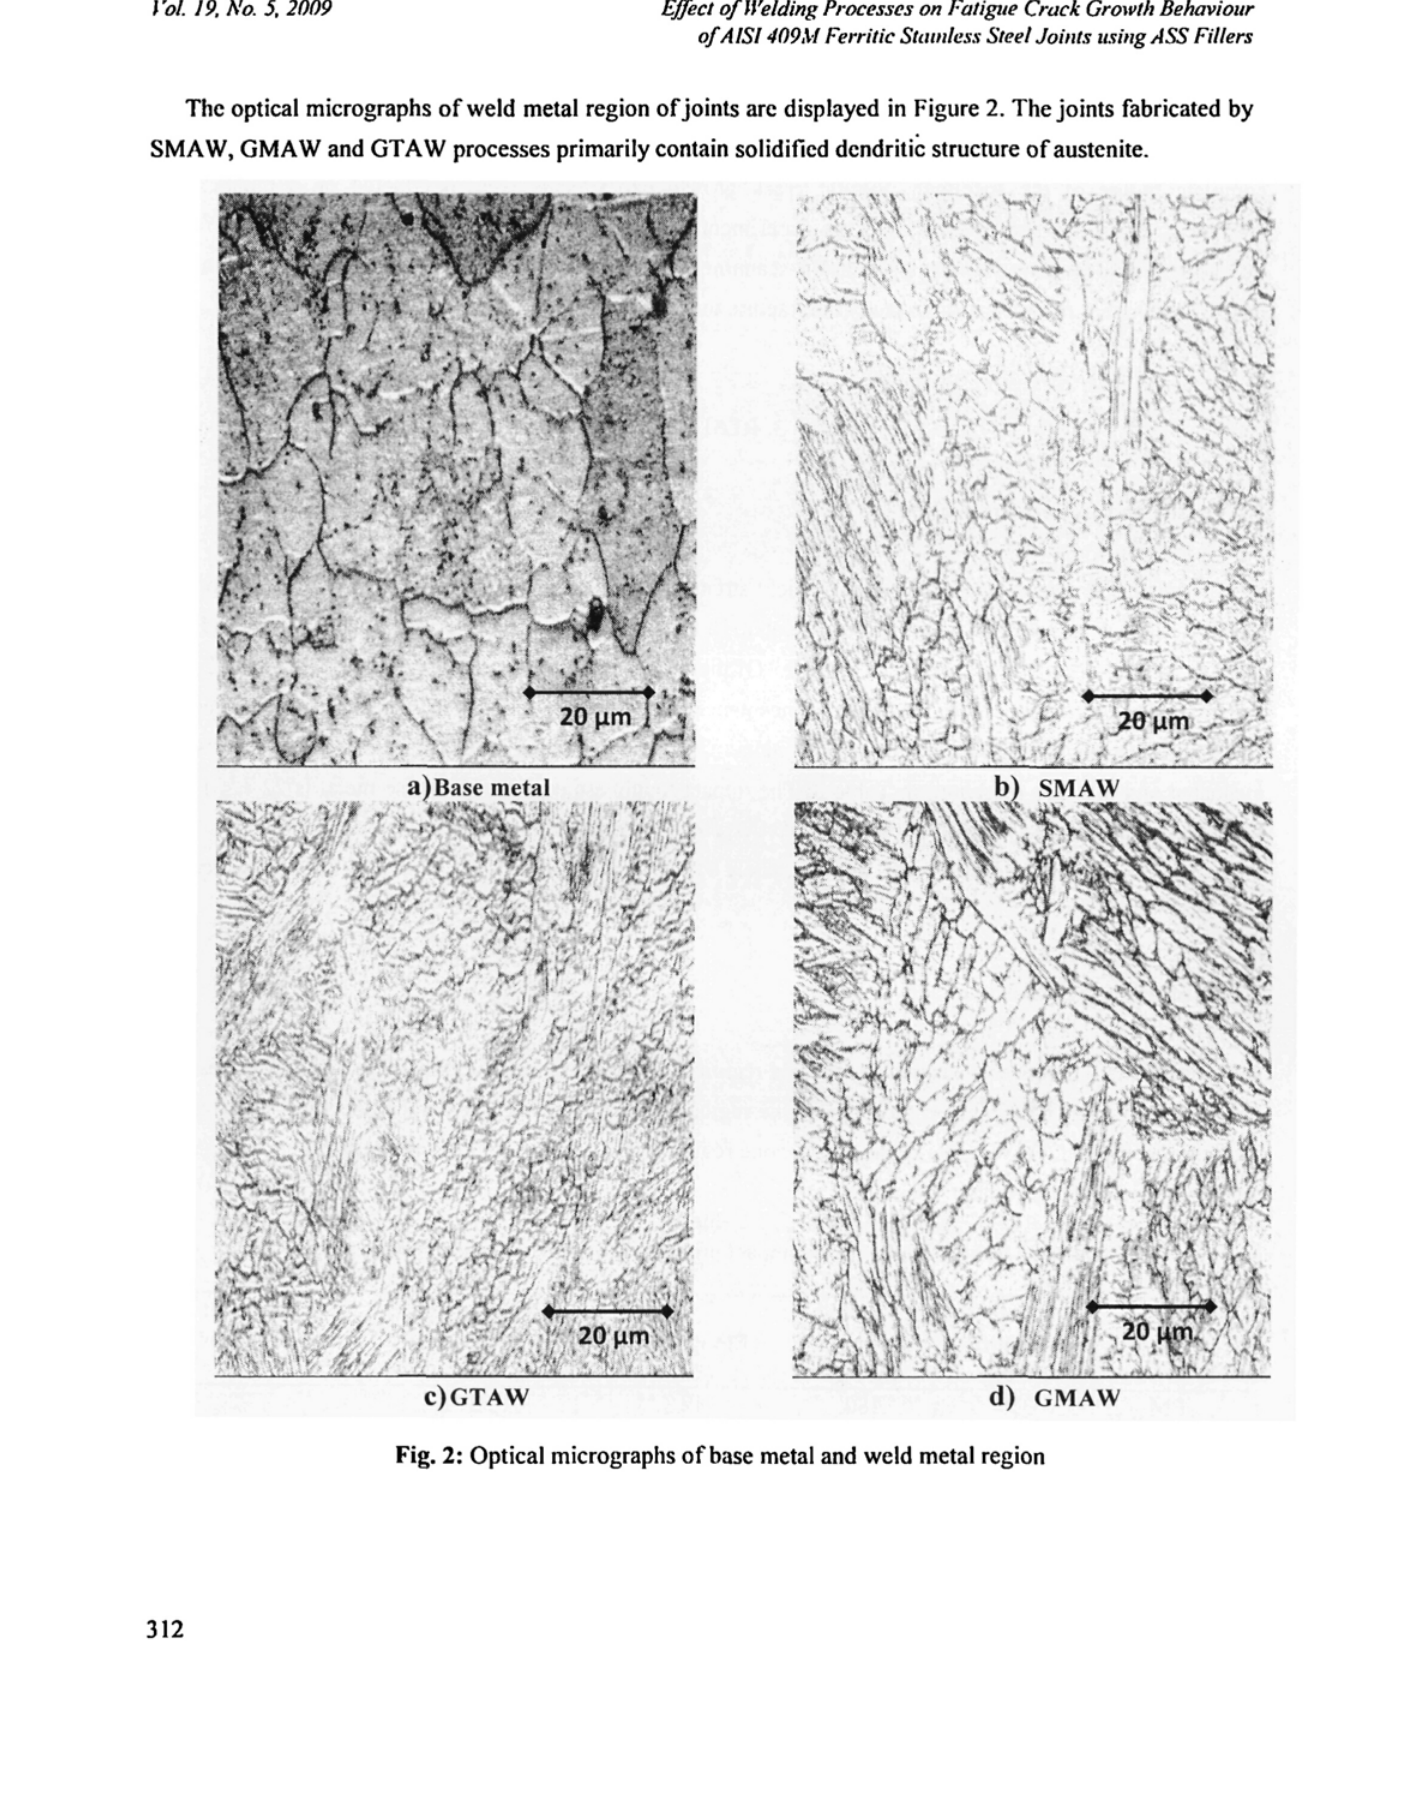
Fig. 2: Optical micrographs of base metal and weld metal